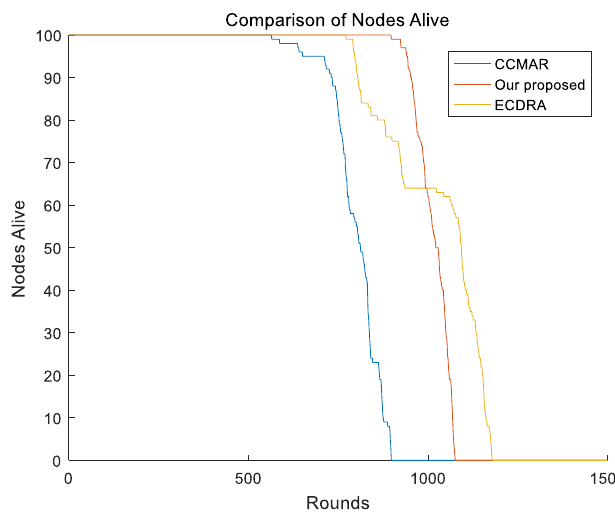
Figure 7. Comparison of the network lifetime between different algorithms.